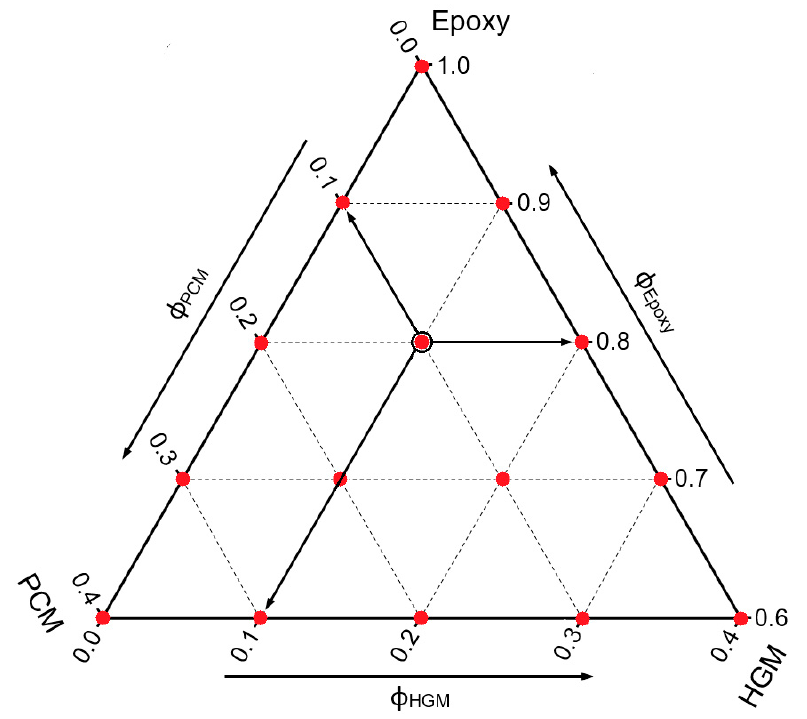
Figure 1. Graphical representation of the prepared compositions (red dots) on the ternary diagram. As example of graph legend, the black-bordered dot refers to the EPG-10.10 foam, having a PCM concentration of 10 vol% and a HGM concentration of 10 vol%.